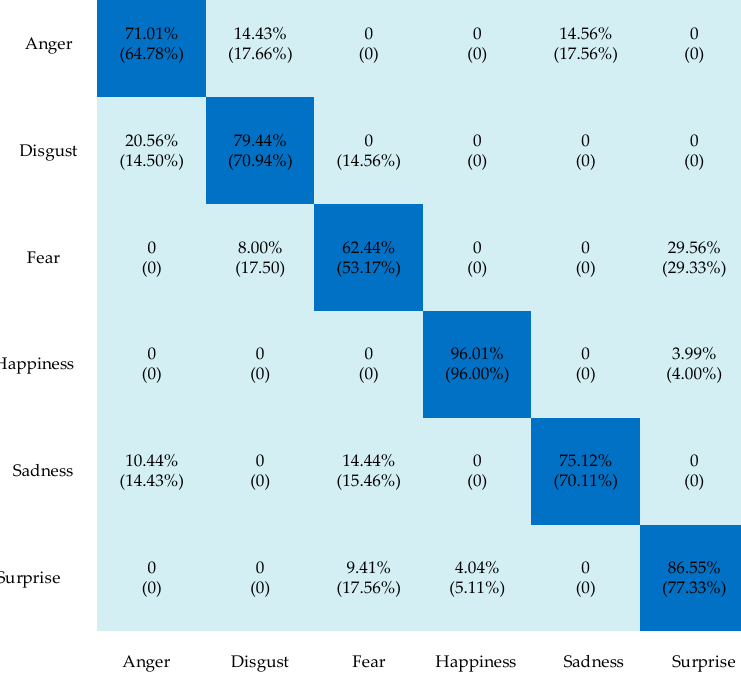
Table 4. Comparisons between our approach and state-of-the-art methods.